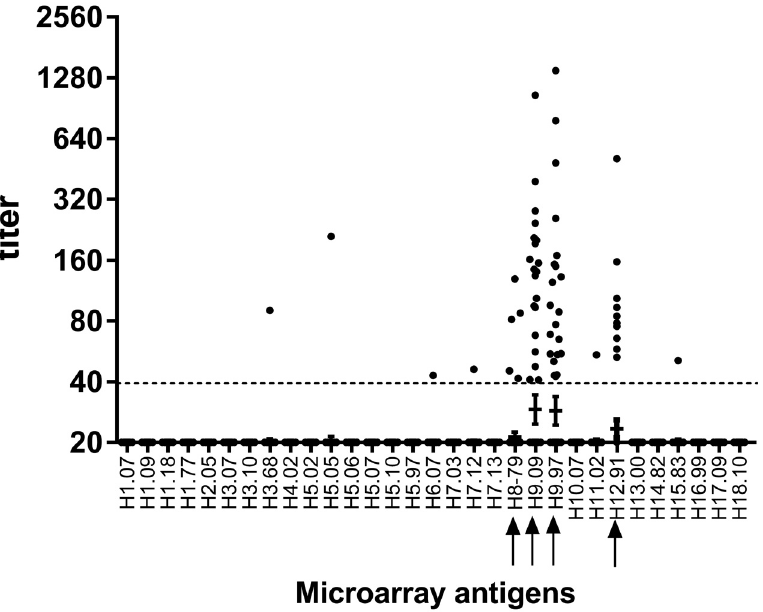
Fig 1. Titers of individual Ghanaian bats plotted against all recombinant proteins included on the microarray. Horizontal bars represent geometric mean titers per antigen including a 95% confidence interval. Sera below fluorescence values of 31.268 (half of the fluorescence spectrum) were regarded as negative and were assigned a titer of 20 (half of the starting dilution of 1:40). Sera above 40 (dashed line) were regarded as positive. Arrows indicate antigens grouping within the same phylogenetic